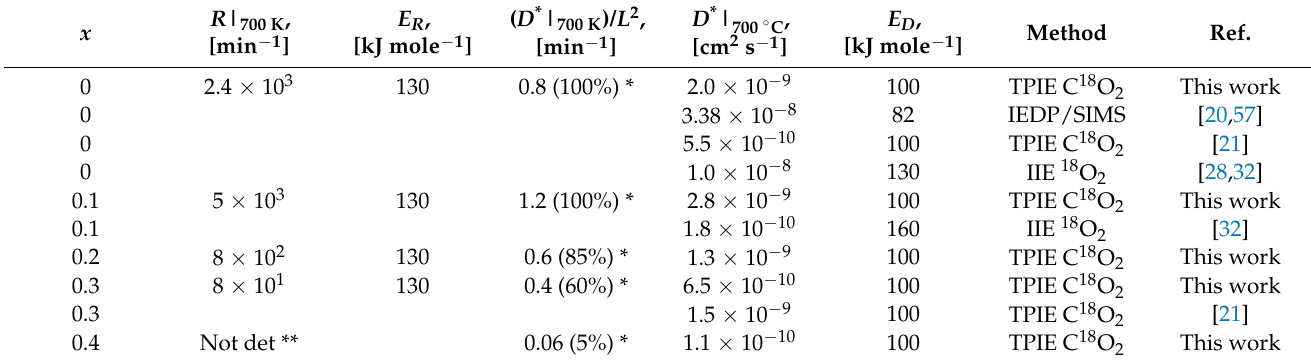
Table 2. Oxygen heteroexchange reaction with a rate R , oxygen diffusion (normalized on particle size) via fast channel with a coefficient D * and their effective activation energies ( E R , E D ) for La 2 − x Ca x NiO 4+ δ